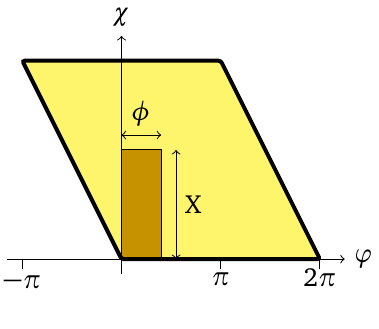
Figure 18: The torus defined by identifications (E.10) in the ( ϕ , χ ) plane, along with the (brown) rectangle (E.11). Without loss of generality, we choose the co- ordinates ( ϕ , χ ) to cover the yellow patch shown here. Edge modes propagate horizontally. Note that the peri- ods (E.10) imply that the entangling region closes when X = 4 π , in which case the rectangle becomes an annular strip that intersects each classical trajectory twice